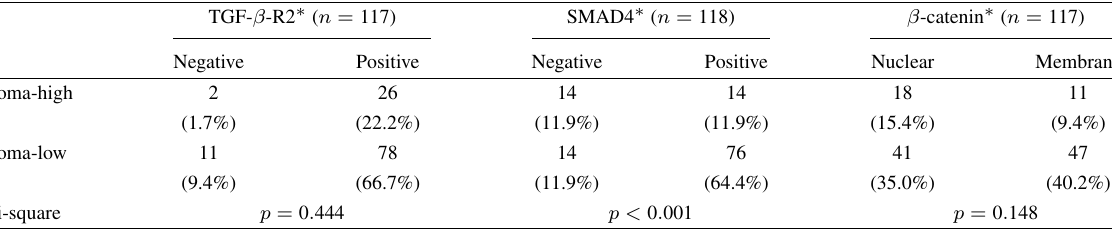
Characteristics of immunostaining for TGF- β -R2, SMAD4, β -catenin in relation to the amount of intra-tumor stroma of the primary